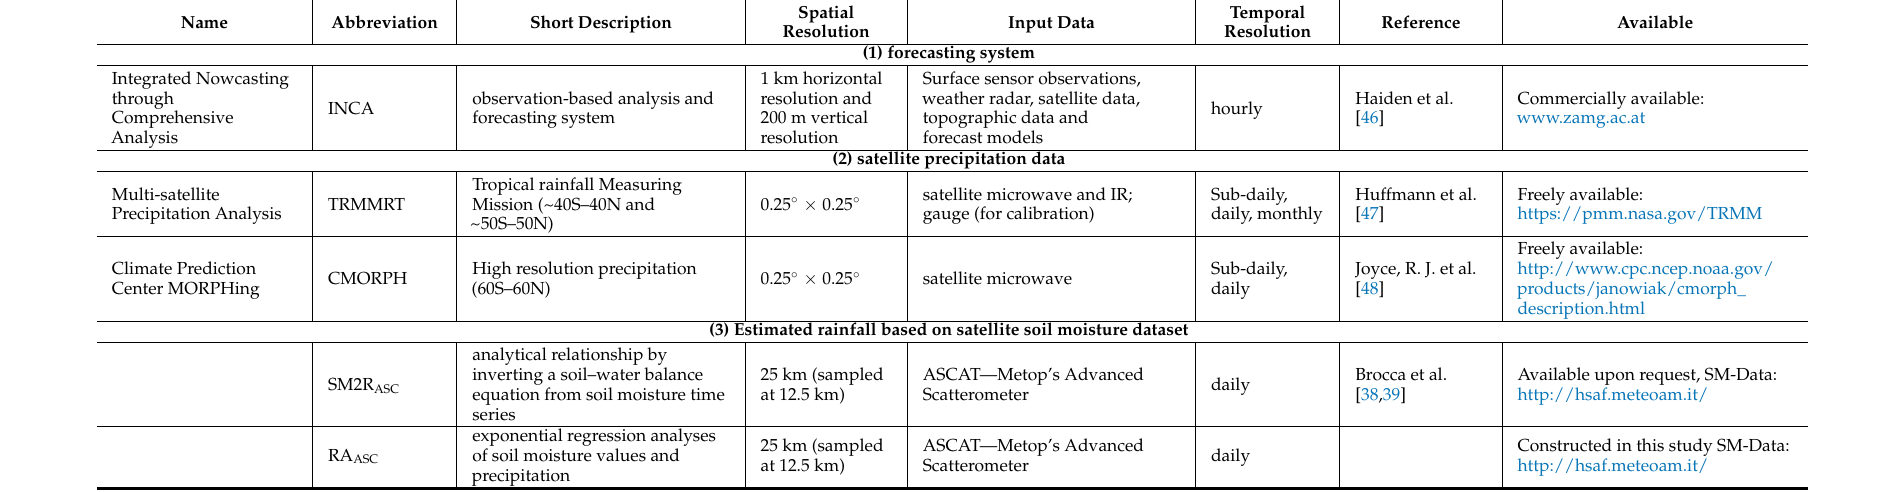
Table 2. Spatial precipitation input datasets in this